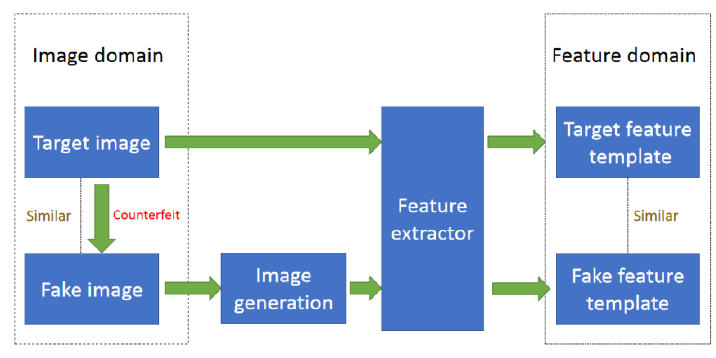
Figure 2. Presentation attack.